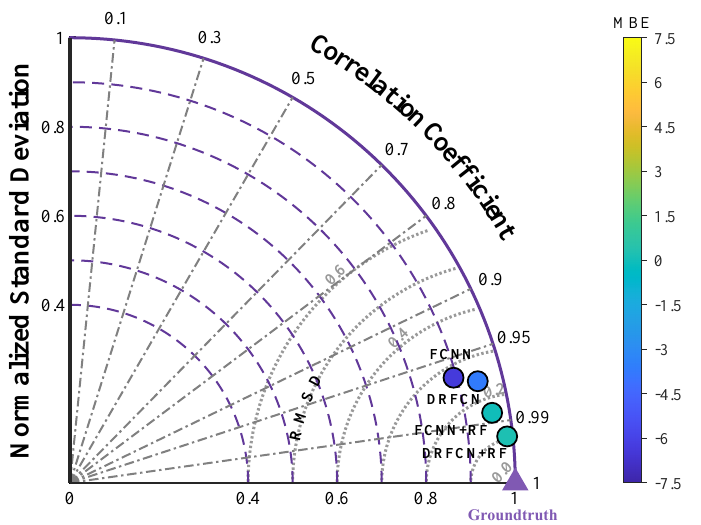
Figure 5. The Taylor diagram that depict R , NSD , and NRMSD for the DRFCN+RF vs. DRFCN, FCNN+RF, and FCNN models on SURFRAD test set. The point labeled groundtruth represents a reference value. The circles represent the models, and the color of each circle represents the nMBE ( % )